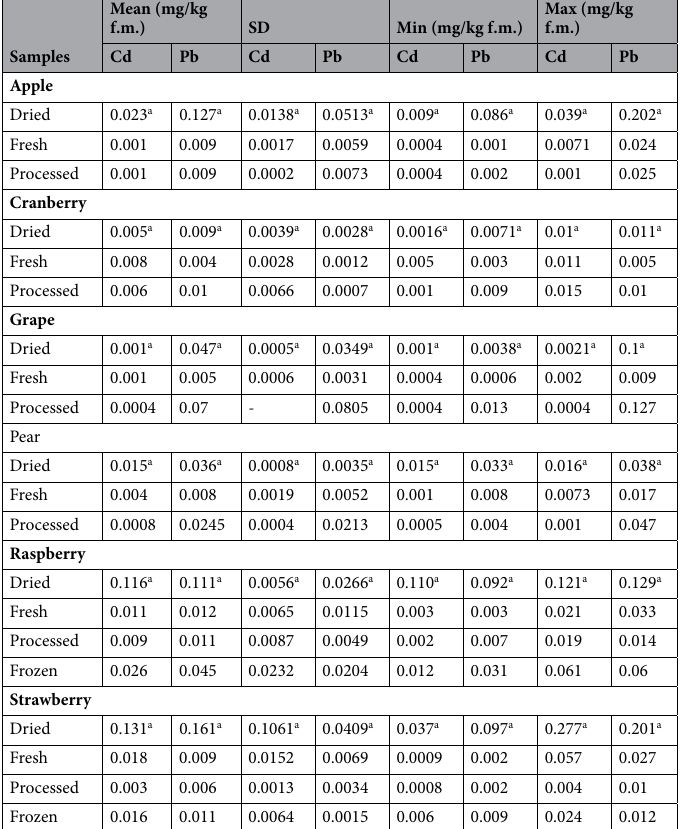
Table 6. The mean value, standard deviation, minimum and maximum values of Cd and Pb concentrations in particular types of fruit samples. a [mg/kg